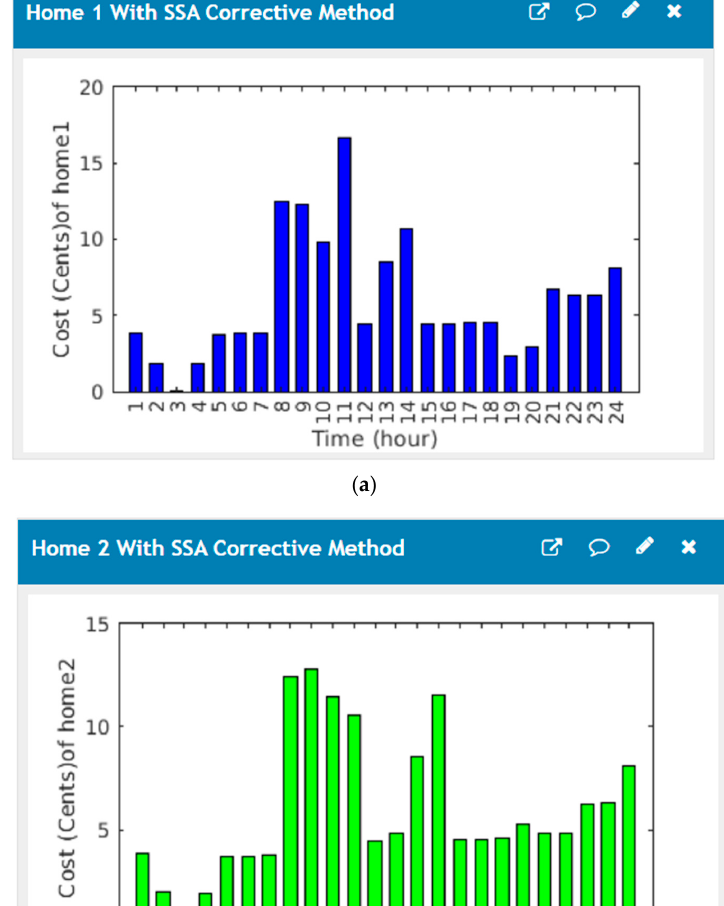
Figure 11. Power GUI of the suggested home structure after implementing the RFA algorithm: ( a )